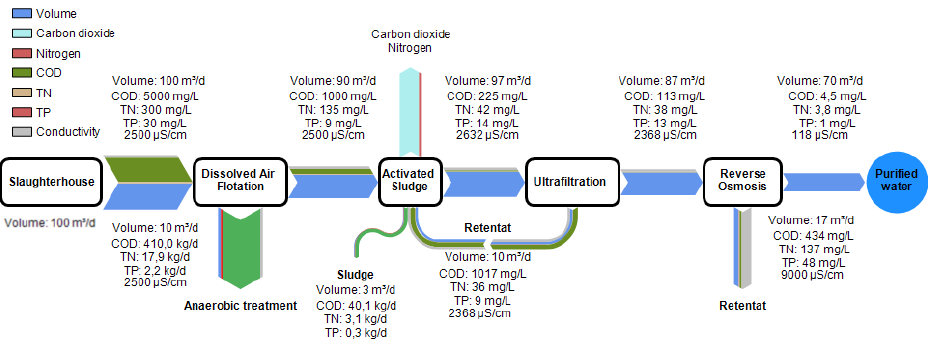
Figure 12. Sankey diagram and flow scheme for option